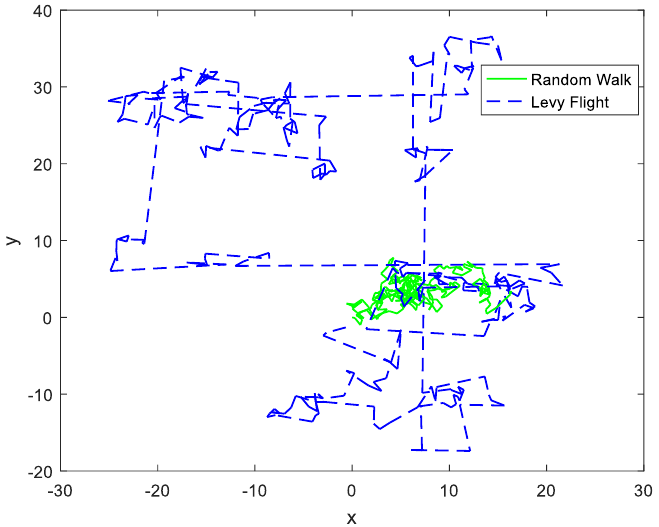
Figure 3. Simulation comparison experiment diagram of Levy flight and random walk.